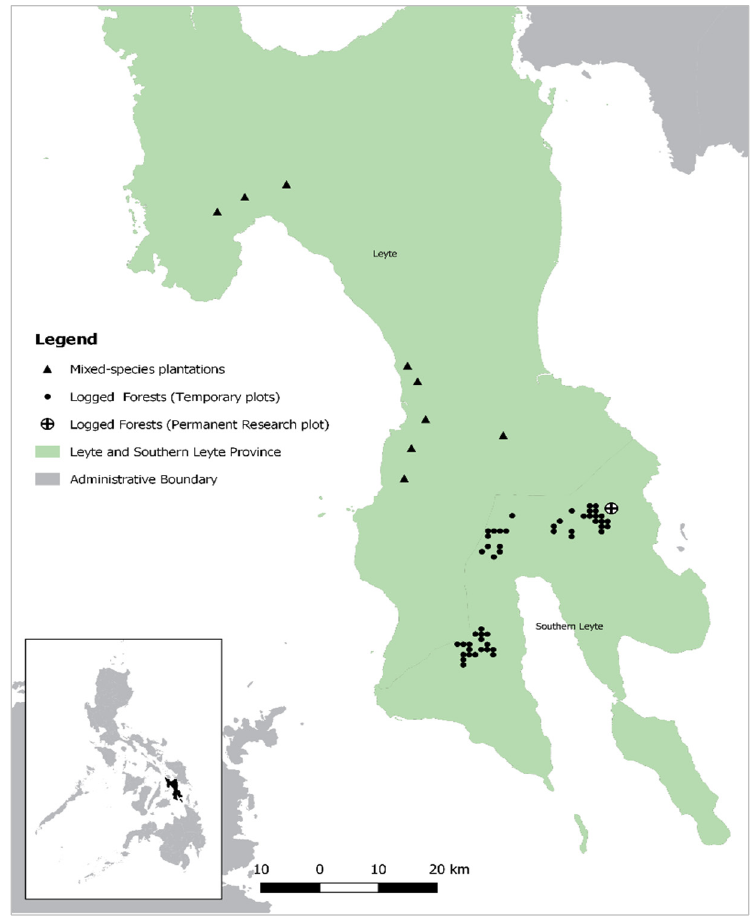
Figure 1. Location map of the study sites in Leyte and Southern Leyte Provinces.